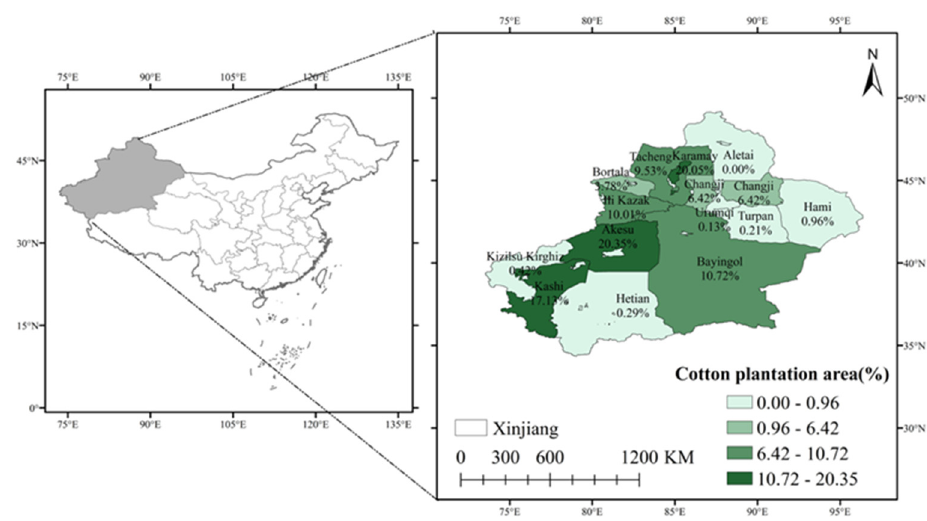
Figure 2. The proportion of cotton area planted in each city to the area of Xinjiang (The source of the data for making the map is “Xinjiang Provincial Statistical Yearbook”.).